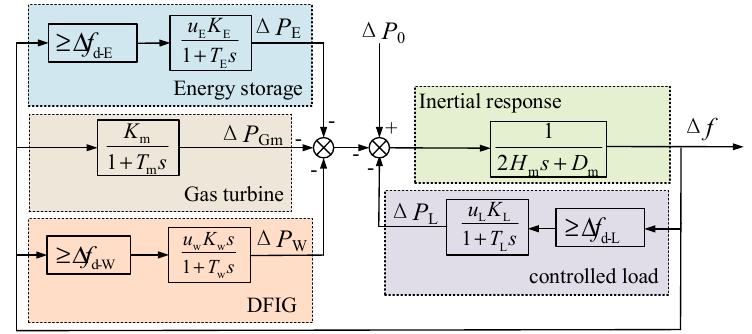
Figure 5. Overall frequency response model of the system.